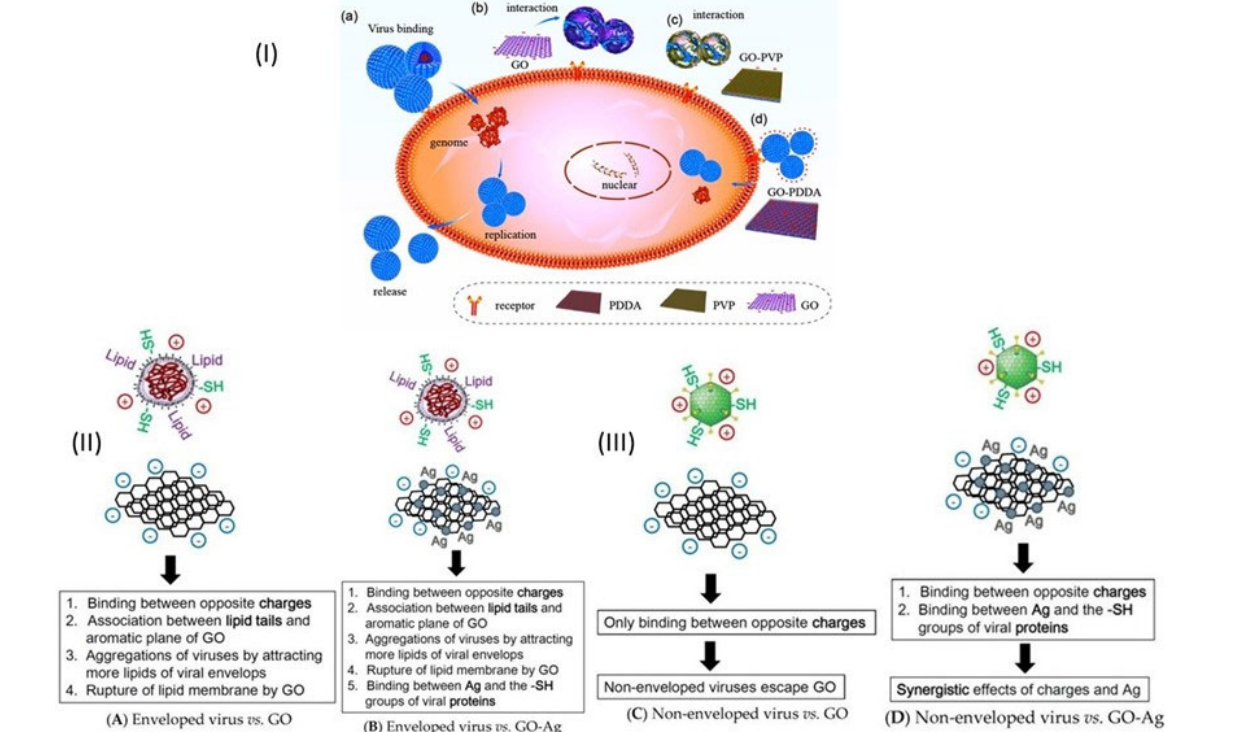
Figure 6. ( I ) Possible Mechanisms of the antiviral activity of GO. ( a ) Normal viruses are absorbed into cells by interacting with cell receptors to initiate infection. ( b ) Negatively charged GO has more chances to interact with the positively charged viruses, leading to virus damage and the inhibition of infection. ( c ) Infection was blocked by GO conjugated with nonionic PVP but not with cationic PDDA ( d ). Reprinted with permission from ref. [5] Copyright 2022 American Chemical Society. ( II , III ) Schematic for the antiviral mechanisms of ( A ) graphene oxide (GO) against the enveloped. virus; ( B ) graphene–silver nanocomposites (GO-Ag) against the enveloped virus; ( C ) GO against the non-enveloped virus; ( D ) GO-Ag against the non-enveloped virus. Reprinted with permission from ref. [113].